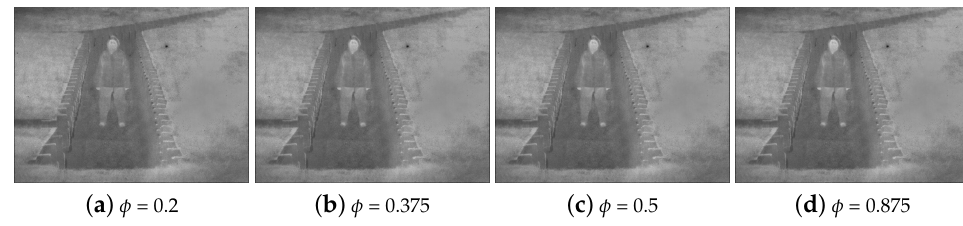
Figure 6. Comparison of different exposedness parameter φ